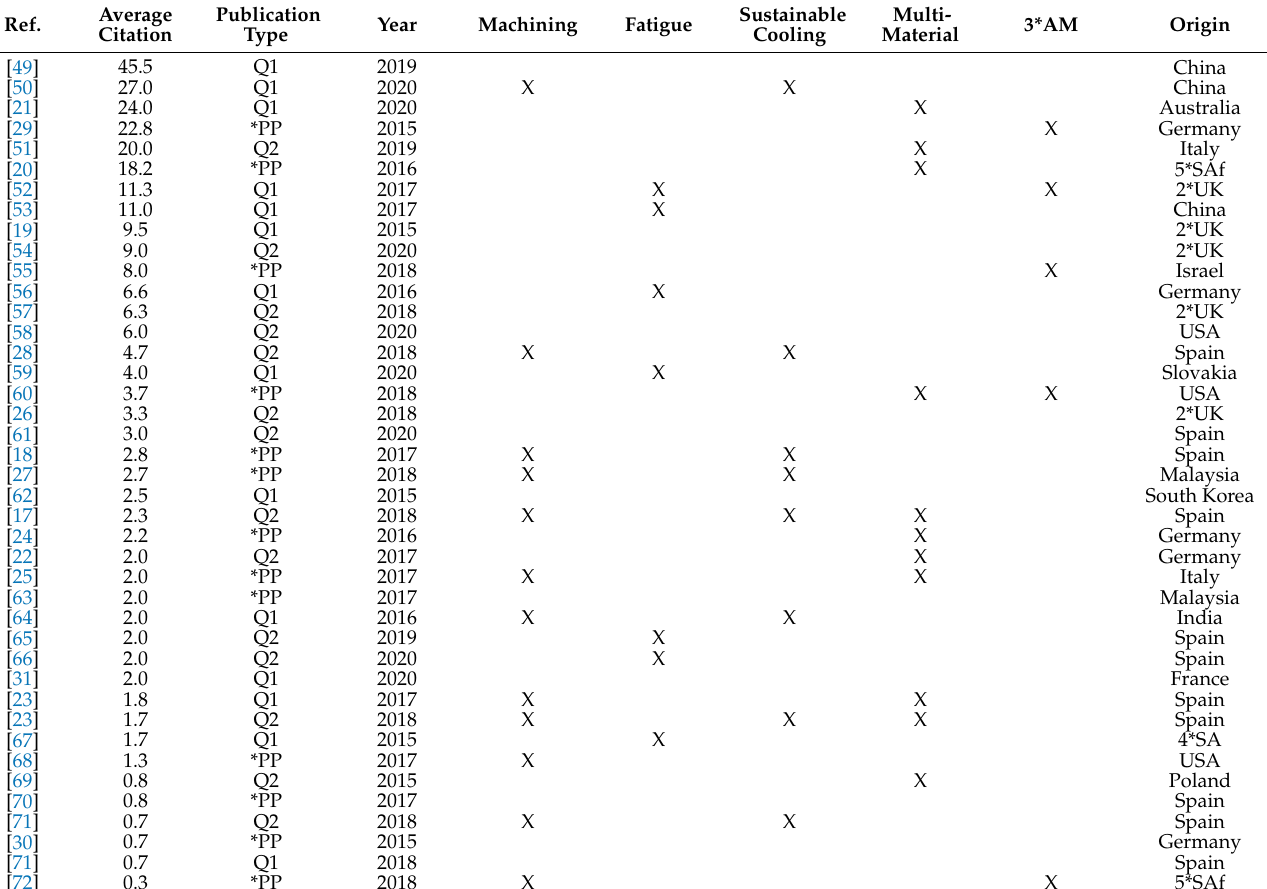
Table 3. General summary of the literature selection, including topics covered.